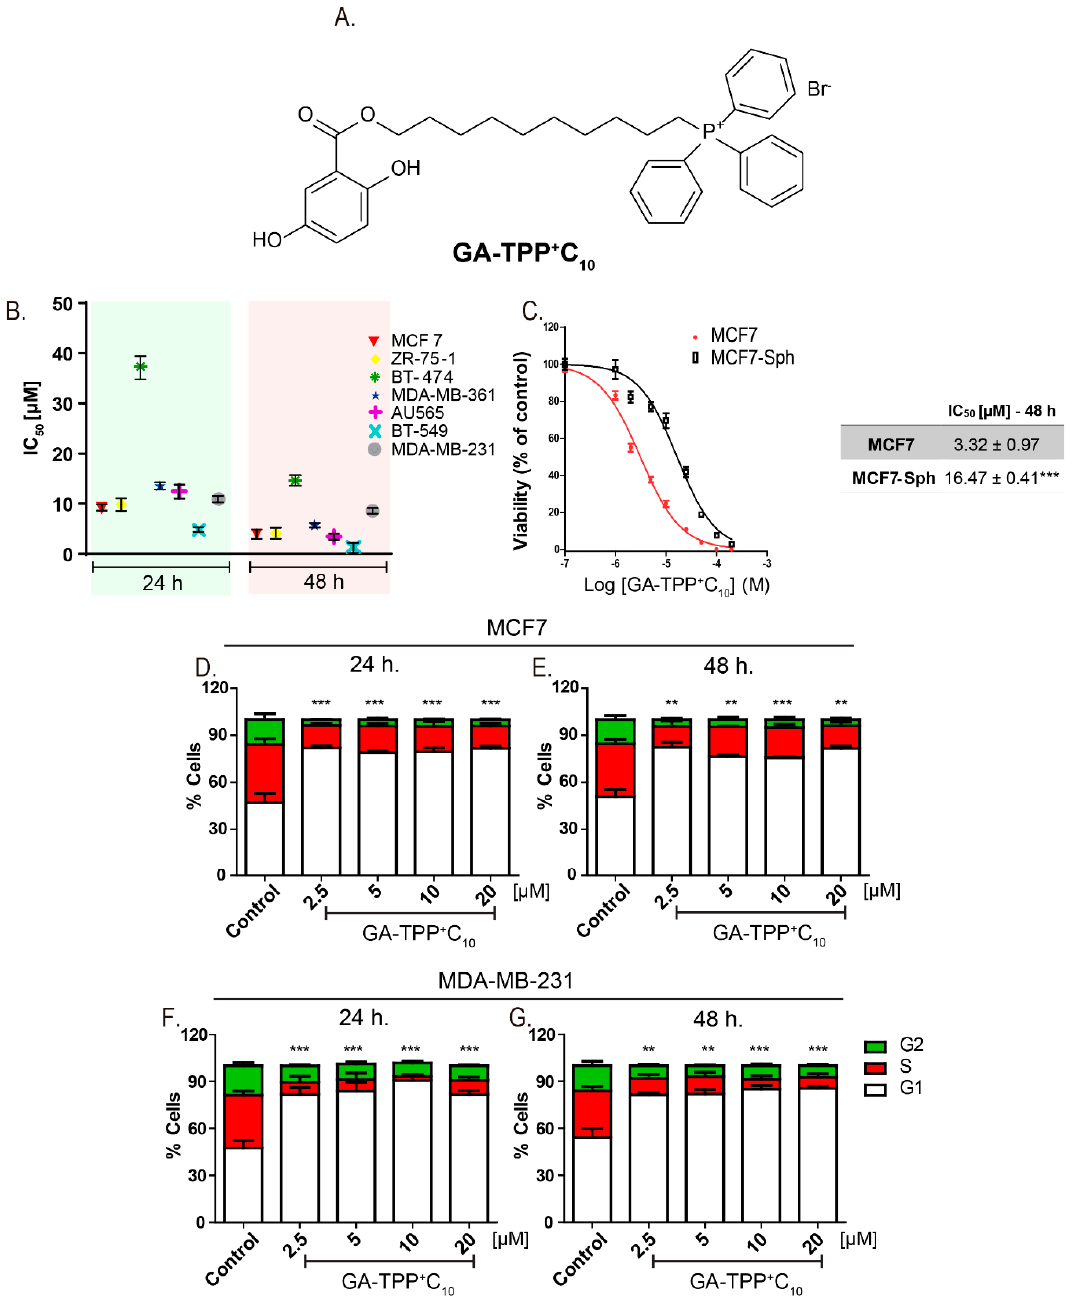
Figure1. GA-TPP + C 10 decreasesthecellviabilityandproducescellcyclearrestinG 1 -phasebreastcancer Figure 1. GA-TPP + C 10 decreases the cell viability and produces cell cycle arrest in G 1 -phase breast cancer (BC) cells. ( A ) Chemical structure of 10-([(2,5-dihydroxybenzoyl)oxy]decyl) (BC) cells. ( A ) Chemical structure of 10-([(2,5-dihydroxybenzoyl)oxy]decyl) triphenylphosphonium triphenylphosphonium bromide (GA-TPP + C 10 ). ( B ) Effect of GA-TPP + C 10 on the MTT reduction of a bromide (GA-TPP + C 10 ). ( B ) E ff ect of GA-TPP + C 10 on the MTT reduction of a panel of BC cells after 24 panel of BC cells after 24 and 48 h and in ( C ) MCF7 spheroids. ( D , E ) Effect of GA-TPP + C 10 on cell cycle and 48 h and in ( C ) MCF7 spheroids. ( D , E ) E ff ect of GA-TPP + C 10 on cell cycle distribution after 24 and distribution after 24 and 48 h in MCF7 and ( F , G ) MDA-MB-231 cells, measured by flow cytometry. 48 h in MCF7 and ( F , G ) MDA-MB-231 cells, measured by flow cytometry. Values are expressed as the Values are expressed as the mean ± SEM of three independent experiments. ** p < 0.01, *** p < 0.001 mean ± SEM of three independent experiments. ** p < 0.01, *** p < 0.001 vs. the G 1 -phase vs. the G 1 -phase control.